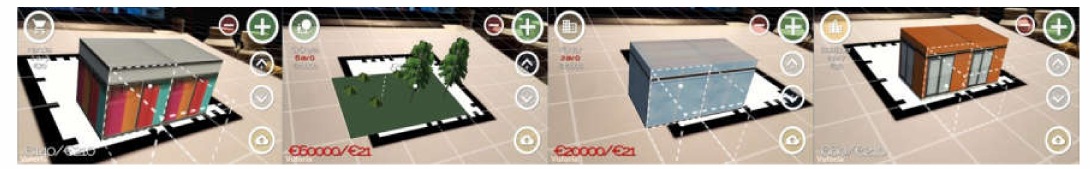
Figure 7. Building cubes with detailed facade textures. From left: commercial, green area, o ffi ce, and residential functions. P7.